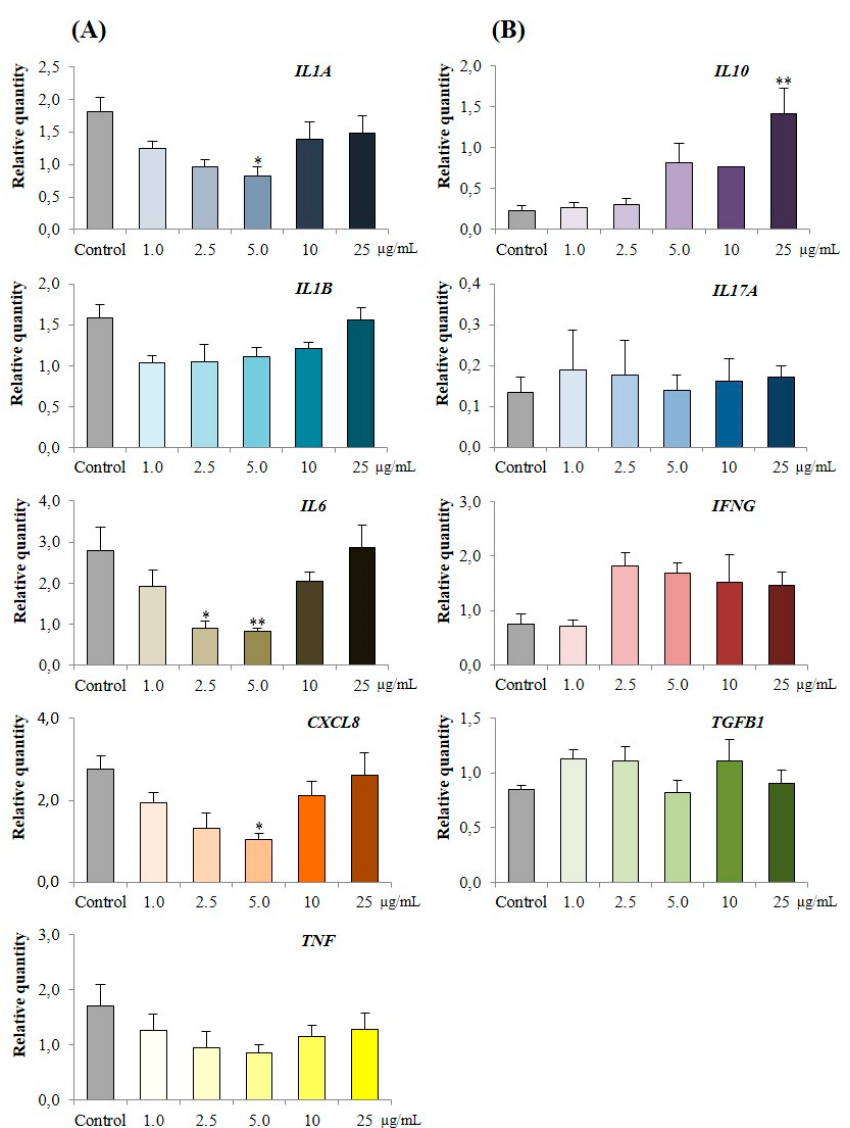
Figure 5. Effect of PPE co-treatment on relative quantity (RQ) of a selected panel of porcine cytokine genes in porcine colonic tissue explants stimulated by LPS, 3 h post-incubation. ( A ) Positively correlated genes. ( B ) Non correlated genes. In both panels, data point “Control” represents porcine colonic tissues stimulated with LPS. After challenge with LPS and co-treatment with PPE, total RNA was extracted, cDNA synthesised and QPCR performed to quantify the relative expression of the selected panel of genes. RQ values were compared to LPS challenged control. Each data point indicates mean ± standard error of 6 independent experiments. * p < 0.05 and ** p < 0.01 in comparison to control, n = 6.